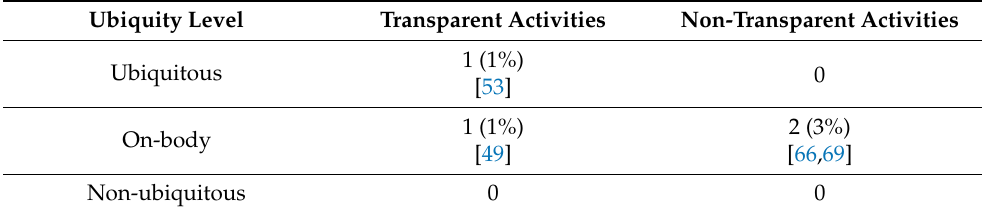
Table 7. Number of studies assessing the sensors’ responsiveness according to the sensors’ ubiquity and transparency levels. The figures in square brackets are the citations for the corresponding studies. The figures in brackets represent the percentage with respect to all 67 studies in the review.